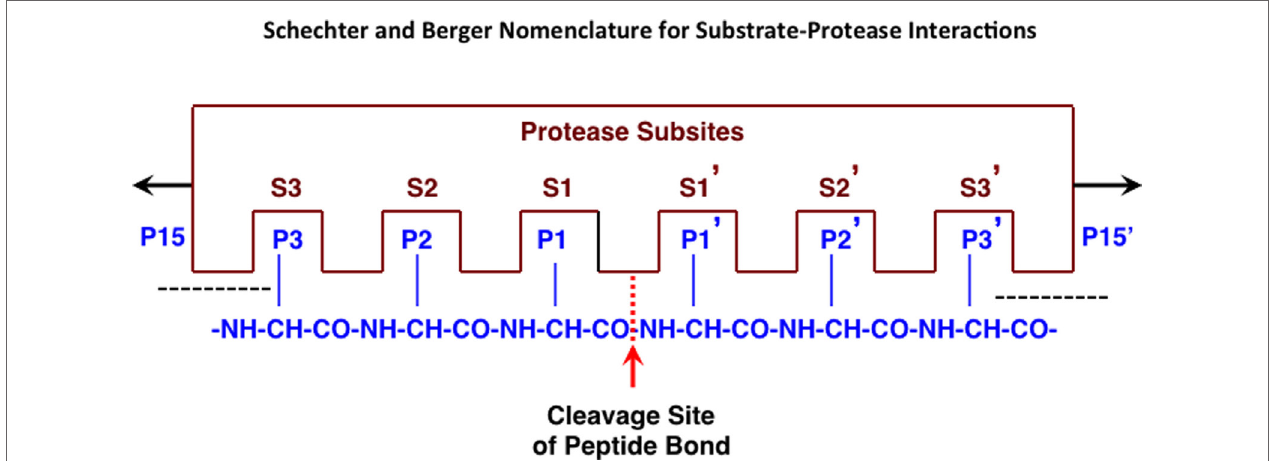
both sides of the catalytic site and are numbered from there in either direction. The positions of the amino acid residues of the peptide substrate represent their locations from the cleaved peptide bonds and have the same numbering as the subsites they occupy (P1–P3 and P1 ′ –P3 ′ ). Cleavage occurs between P1 and P1 ′ residues. Figure revised from Ref.